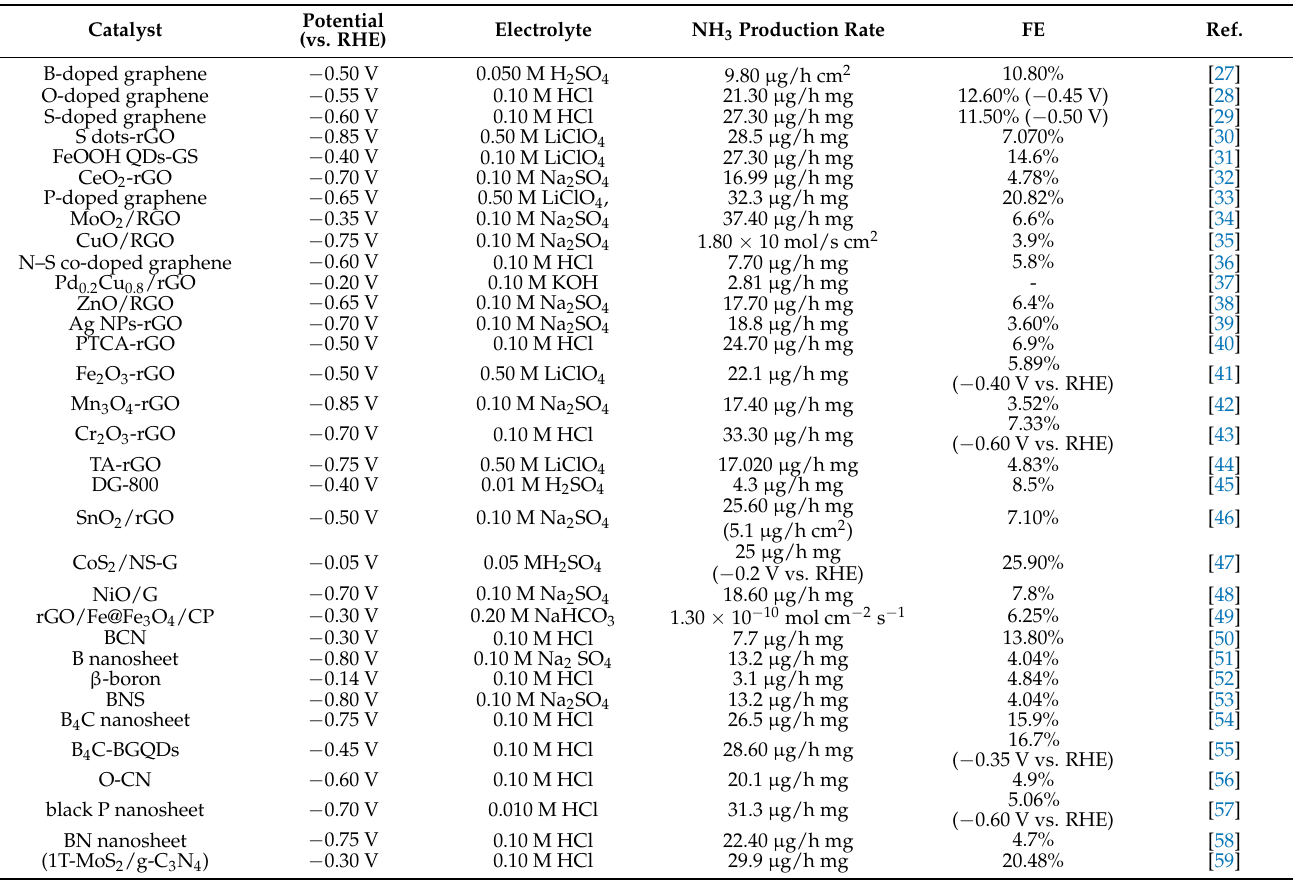
Table 1. Application of electrocatalysts based on 2D non-metallic nanomaterials.